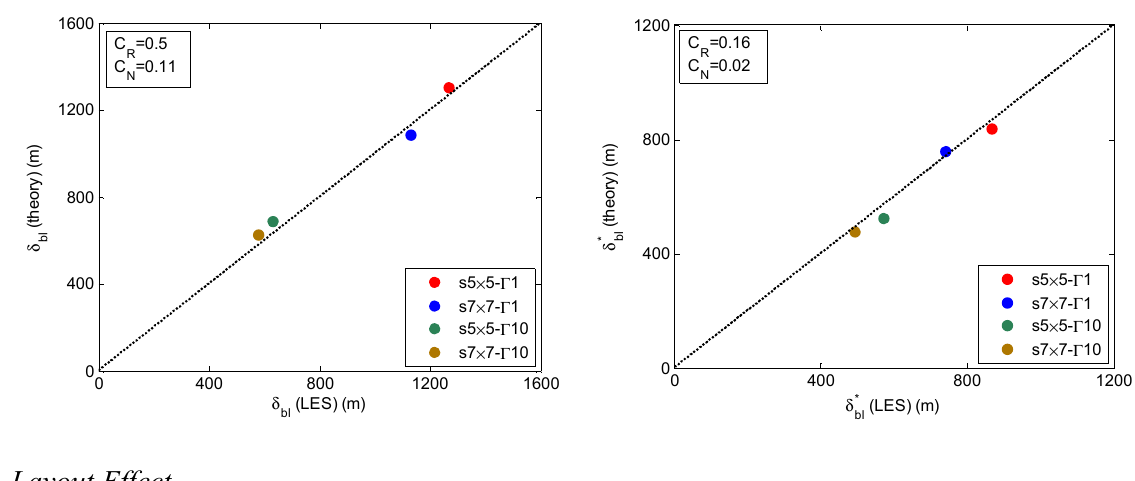
Figure 8. Correlation between δ from